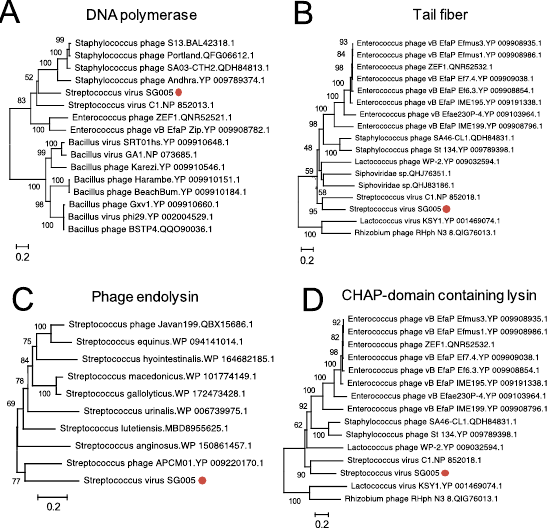
Figure 5. Phylogenetic analysis of some CDSs of Ø SG005. Phylogenetic trees of DNA polymerase ( A ), tail fiber protein ( B ), endolysin ( C ), and CHAP-domain containing lysin ( D ) were constructed by the neighbor-joining method (1000 replications) based on the full-length amino acid sequences. Bootstrap values are shown on the branch nodes, and the scale bar represents a distance of 0.2 substitutions per site. Red circles indicate Ø SG005.